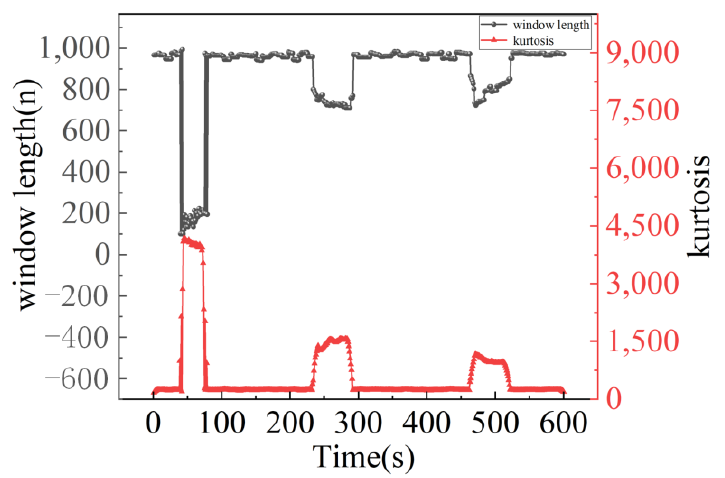
Figure 6. Comparison between kurtosis change and adaptive window length change.